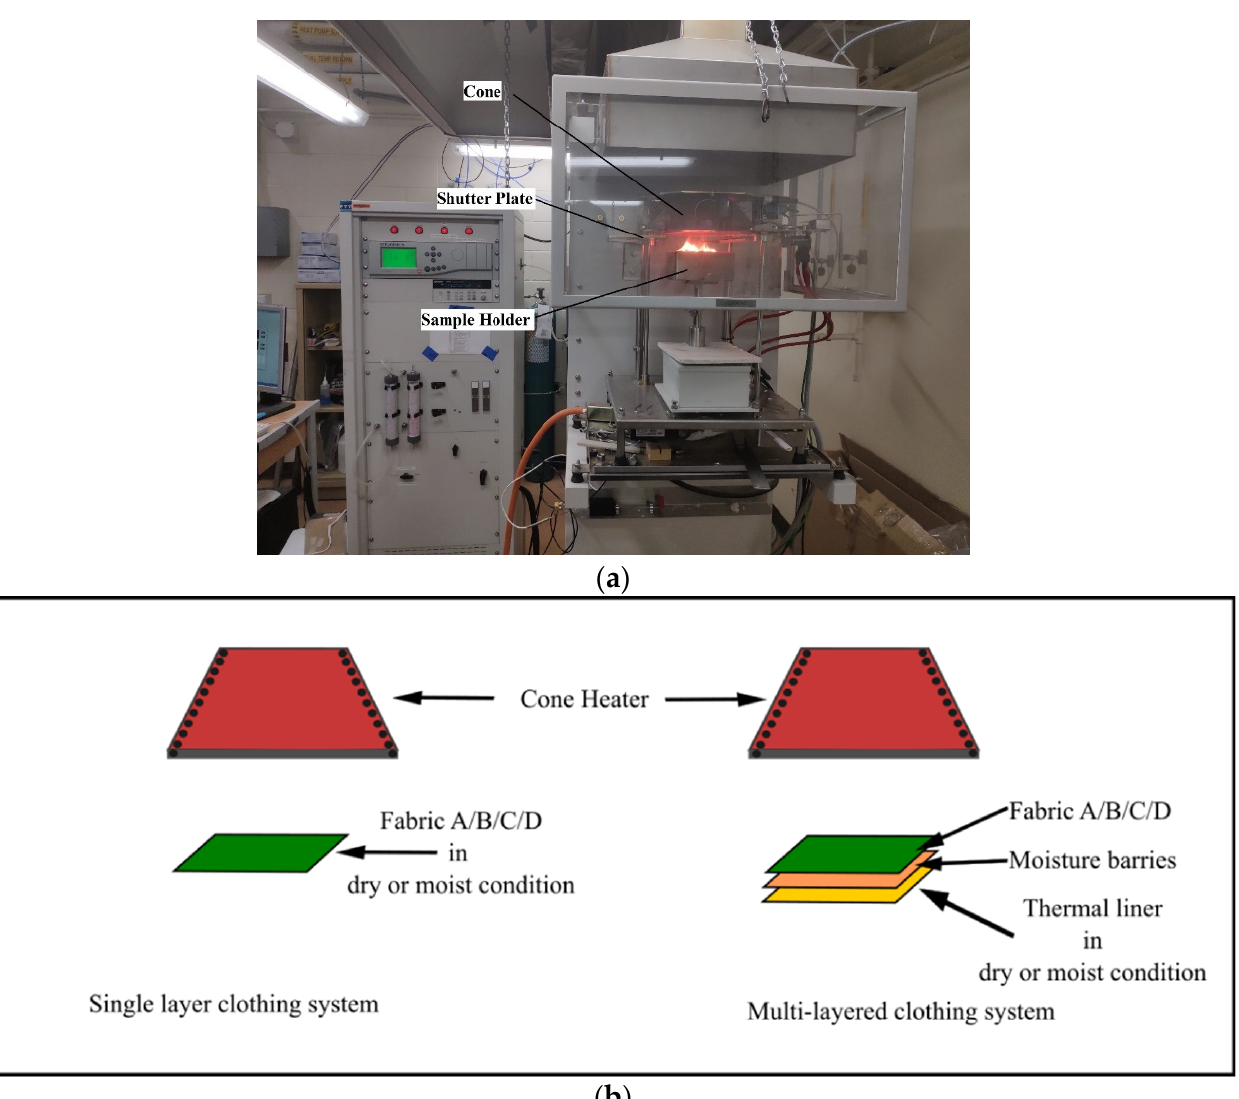
Figure 3. ( a ) Cone calorimeter. ( b ) Schematic diagram of heat exposure of single and multi-layered fabric